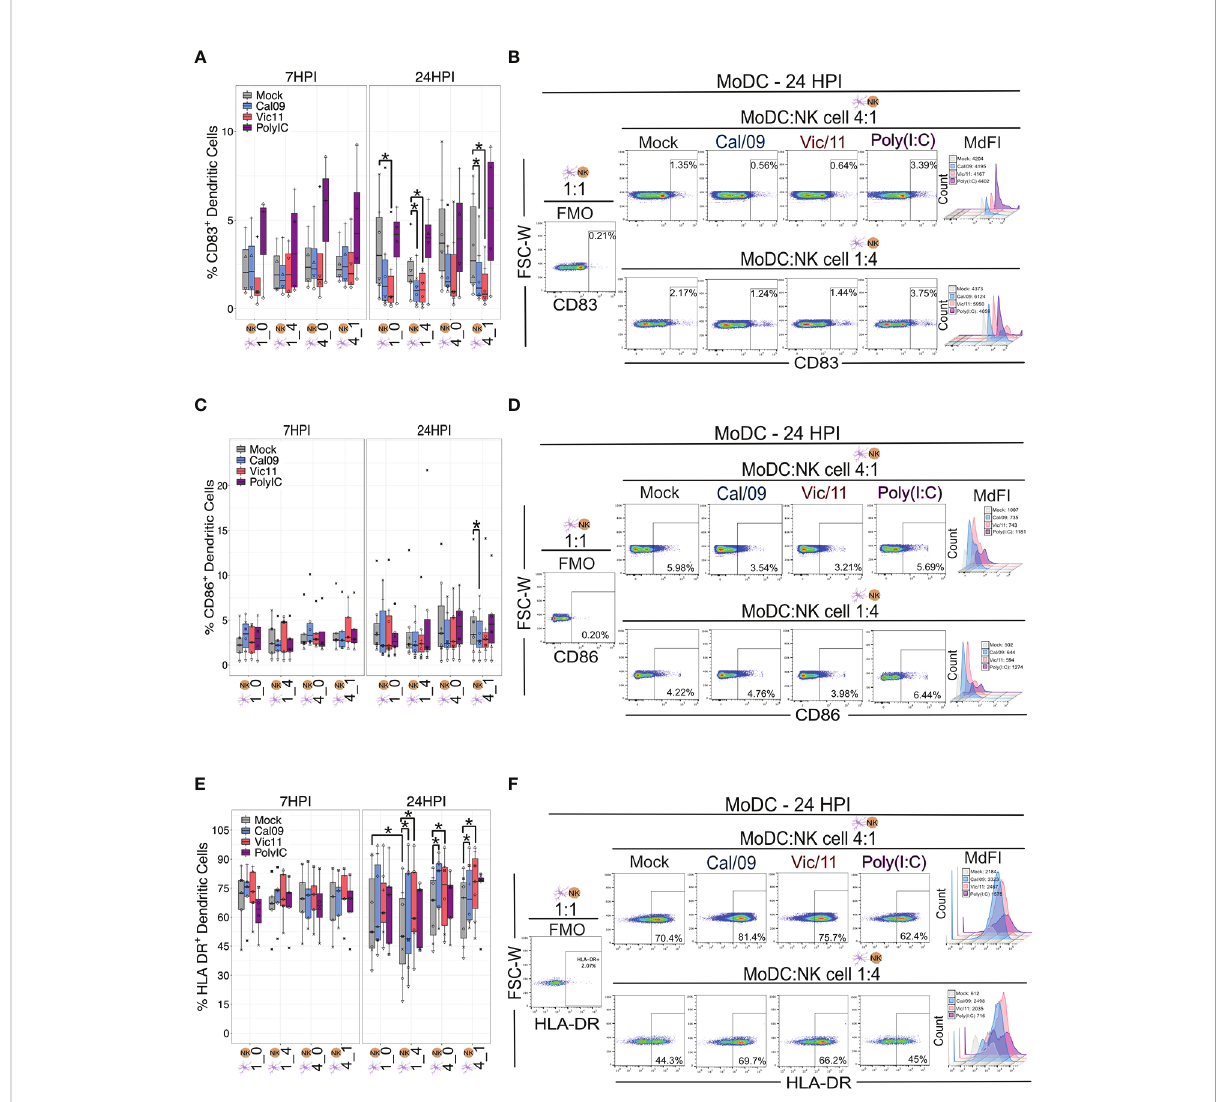
FIGURE 2 IAV exposure leads to the downregulation of CD83 and CD86 and upregulation of HLA-DR on MoDCs in co-culture with NK cells. (A) Summary plot of the frequency of CD83 + Cal/09- or Vic/11-exposed MoDCs (MOI = 3) cultured alone (1:0, 4:0) or after a 7 h ( n = 4) or 23 h ( n = 6) co- culture with NK cells at indicated cell ratio as assessed by fl ow cytometry using an antibody speci fi c to CD83. (B) Representative fl ow plot of CD83 + frequency and median fl uorescence intensity (MdFI) on MoDCs at a MoDC to NK cell ratio of 4:1 (top panel) or 1:4 (bottom panel) at 24 HPI (MOI = 3). (C) Summary plot of the frequency of CD86 + Cal/09- or Vic/11-exposed MoDCs (MOI = 3) cultured alone (1:0, 4:0) or after a 7 h ( n = 5) or 23 h ( n = 7) co-culture with NK cells at indicated cell ratio as assessed by fl ow cytometry using an antibody speci fi c to CD86 (D) Representative fl ow plot of CD86 + frequency and MdFI on MoDCs at a MoDC to NK cell ratio of 4:1 (top panel) or 1:4 (bottom panel) at 24 HPI (MOI = 3). (E) Summary plot of the frequency of HLA-DR + Cal/09- or Vic/11-exposed MoDCs (MOI = 3) cultured alone (1:0, 4:0) or after a 7 h ( n = 5) or 23 h ( n = 7) co-culture with NK cells at indicated cell ratio as assessed by fl ow cytometry using an antibody speci fi c to HLA-DR. (F) Representative fl ow plot of HLA-DR + frequency and MdFI on MoDCs at a MoDC to NK cell ratio of 4:1 (top panel) or 1:4 (bottom panel) at 24 HPI (MOI = 3). Poly (I:C) treatment served as a positive control. The same shape between conditions indicates that the data point is derived from the same donor. * p < 0.05, Wilcoxon signed-rank